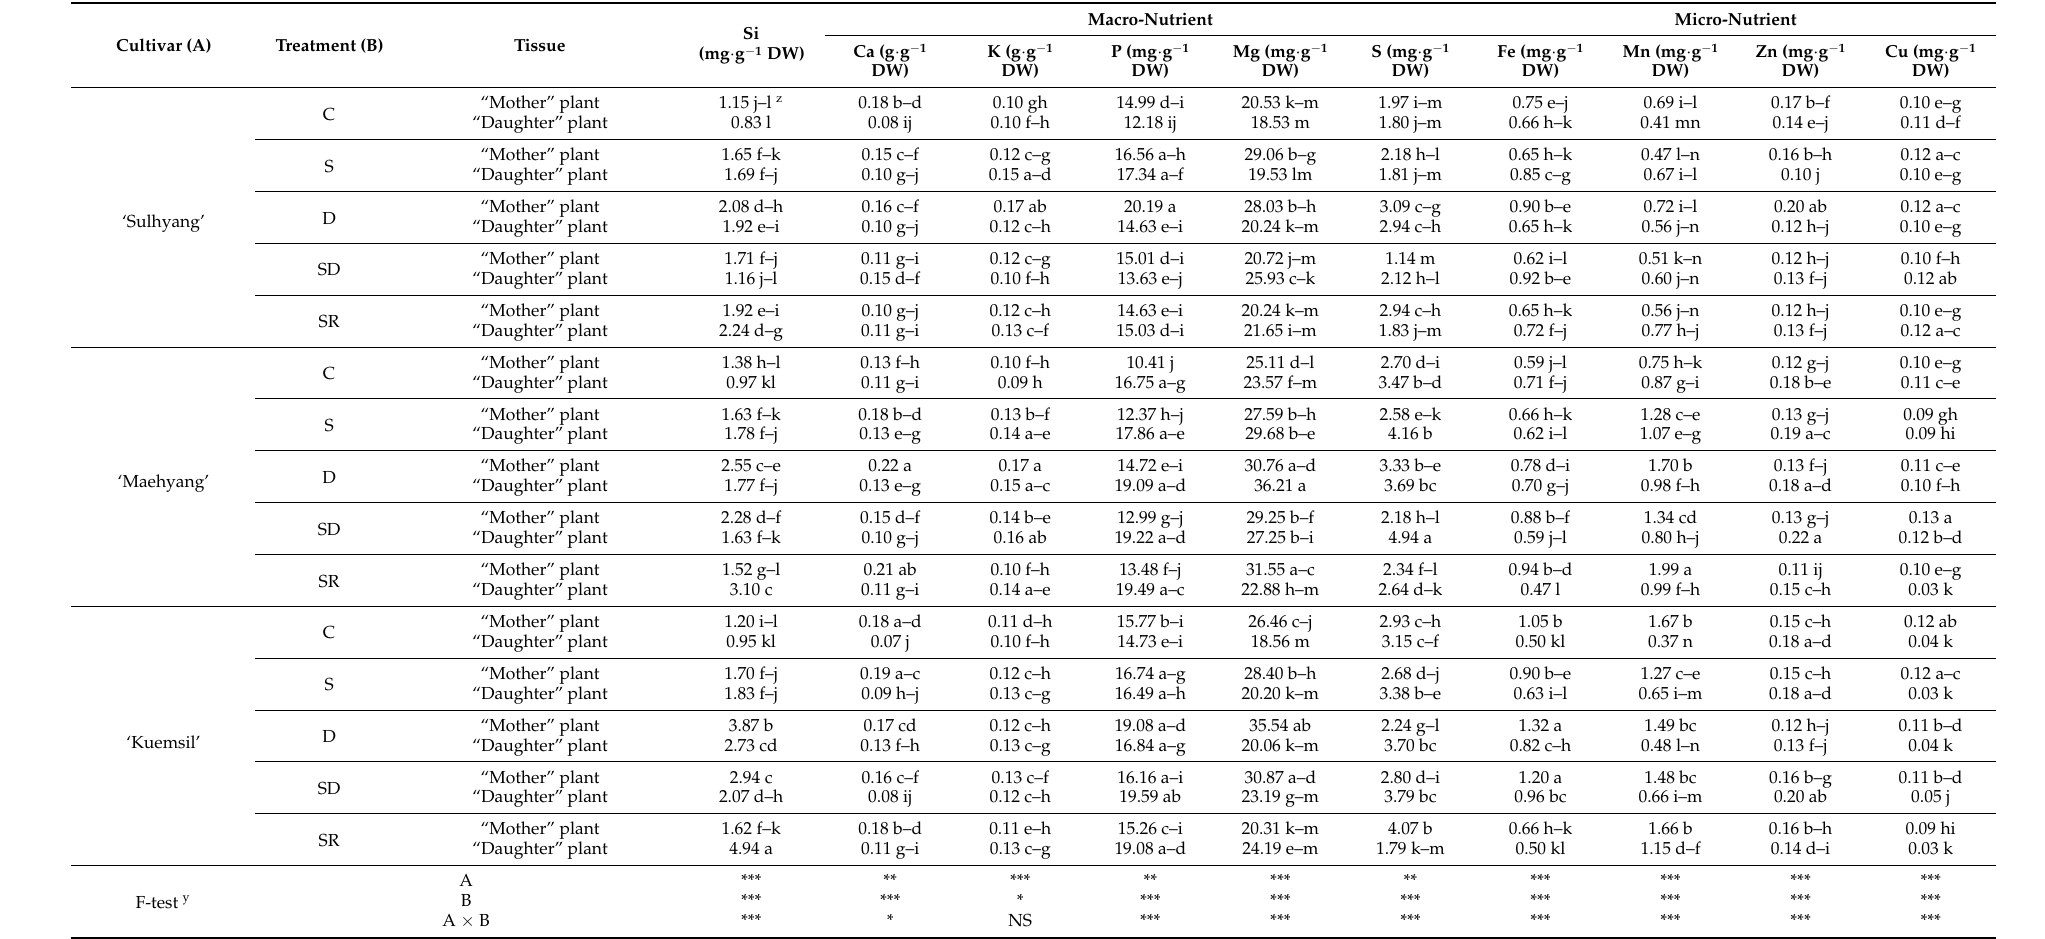
Table 2. Mineral contents in strawberry plants as affected by different Si